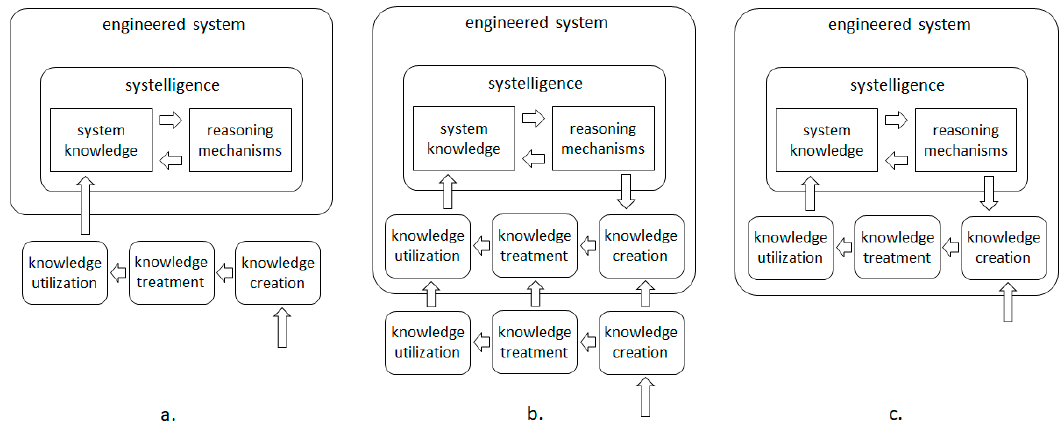
Figure 3. Approaches of processing system knowledge: ( a ) system-external approach, ( b ) combined approach, and ( c ) system-internal approach.